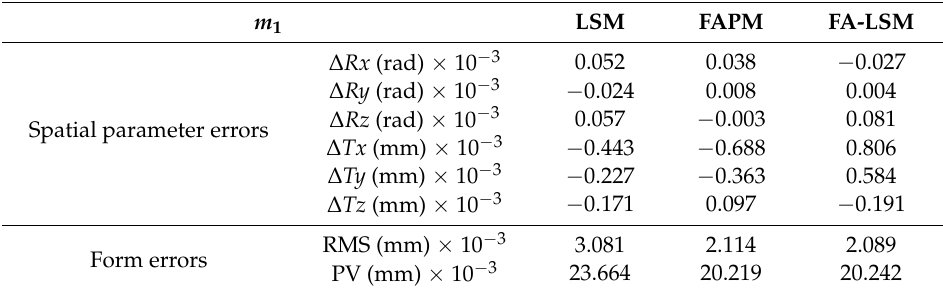
Table 1. Evaluated errors of the six spatial parameters and the form accuracy. m 1